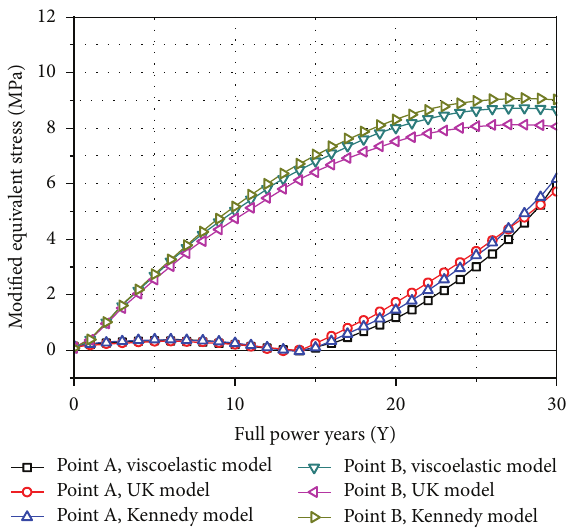
Figure 6: Stress history in service life of ATR-2E graphite